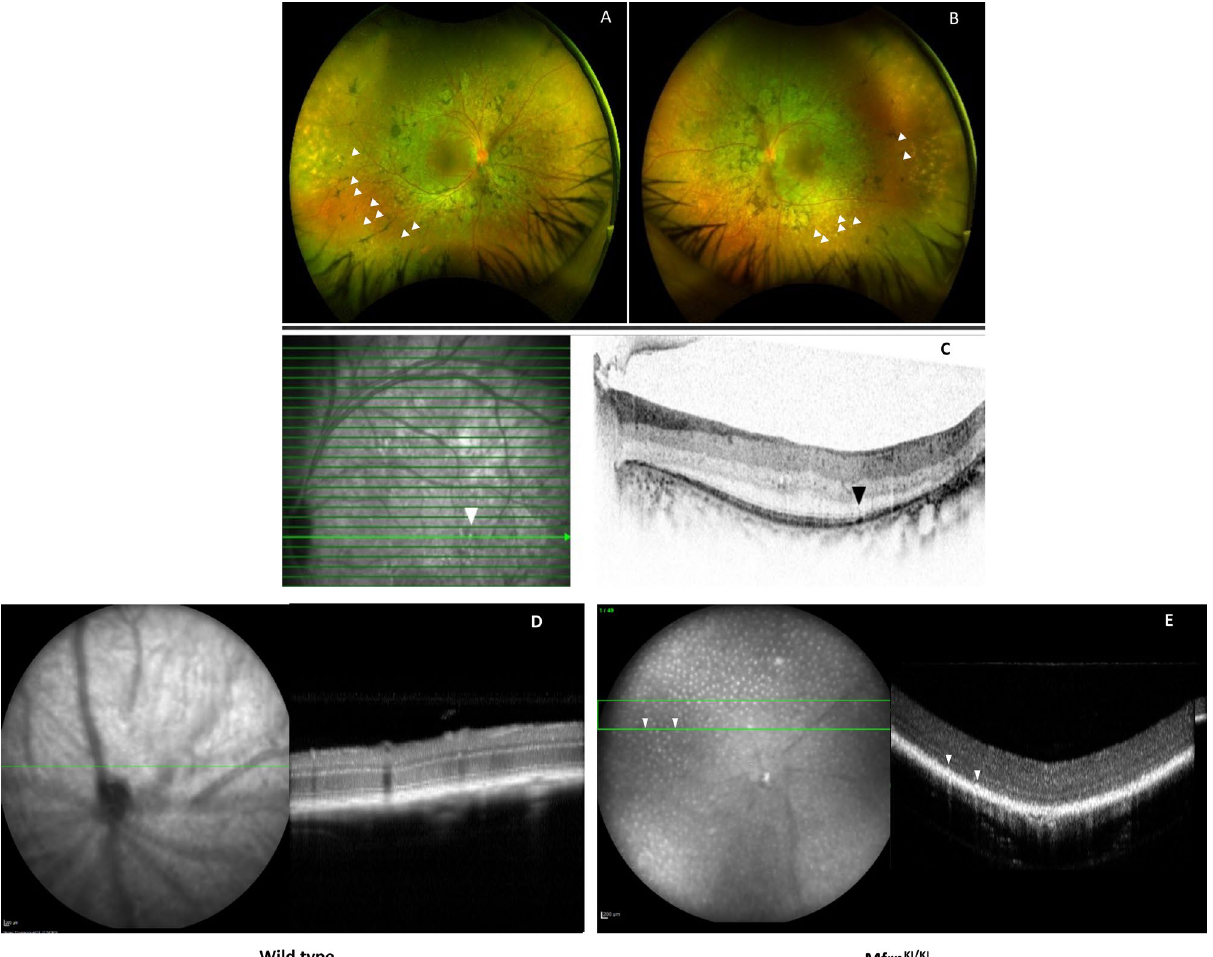
Figure 1. Imaging from a 53-year-old female patient with homozygous c.498_499insC mutations in MFRP. ( A,B ) Ultra-widefield pseudo-color imaging from ( A ) right, ( B ) left eyes demonstrate signs of retinal degeneration with symmetrical retinal pigmentation and atrophy with relative sparing of central macula. Additionally, the imaging demonstrates multiple creamy white spots in the far and mid-periphery bilaterally (arrowheads). ( C ) Spectral domain optical coherence tomography aligned with near infrared imaging isolates one of the white spots in the macula (white arrowhead) and demonstrates a subretinal location of this spot (black arrowhead). ( D,E ) SLO images showing multiple autofluorescent spots in the fundus of WT and Mfrp KI/ KI mice